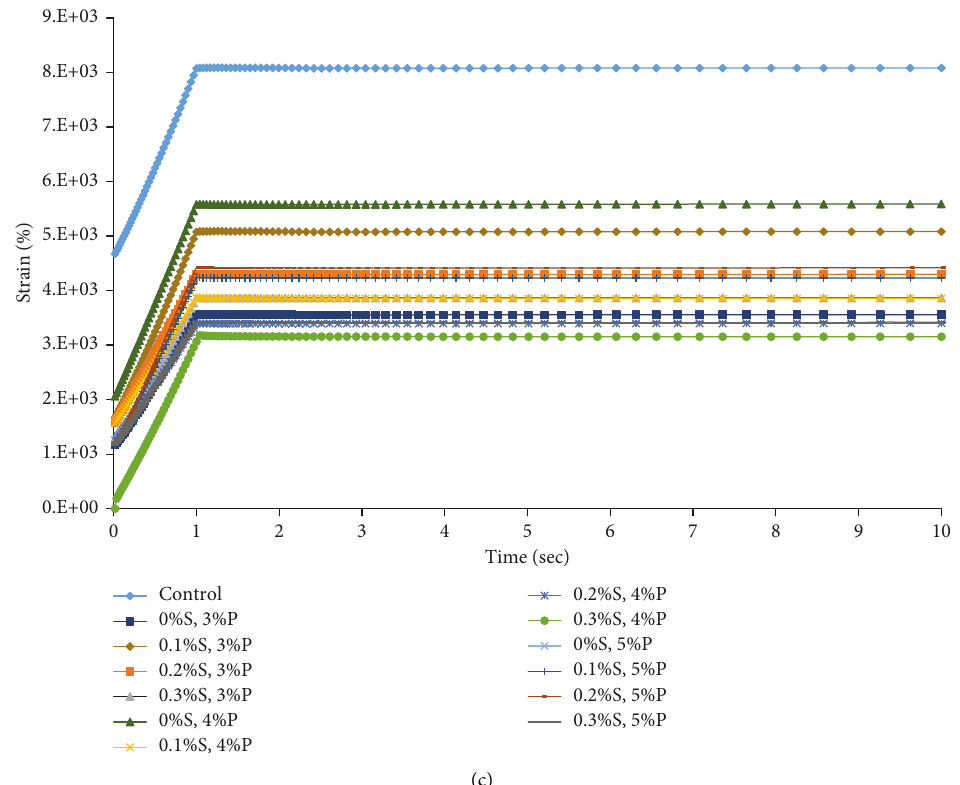
Figure 7: Single-cycle strain of base and modified binders for different contents of sulfur and polymer tested at a stress level of 3.2kPa for testing temperatures of (a) 58 ° C, (b) 64 ° C, and (c) 70 °